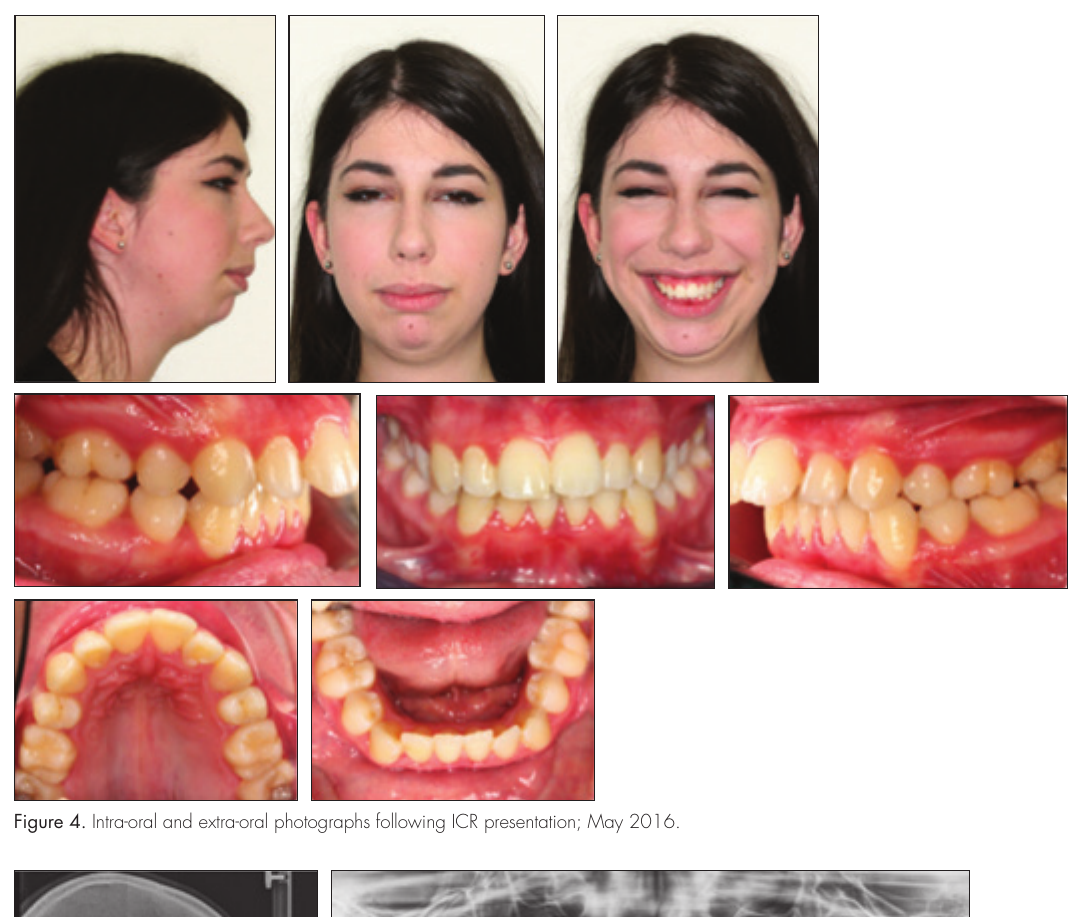
Figure 4. Intra-oral and extra-oral photographs following ICR presentation; May 2016.